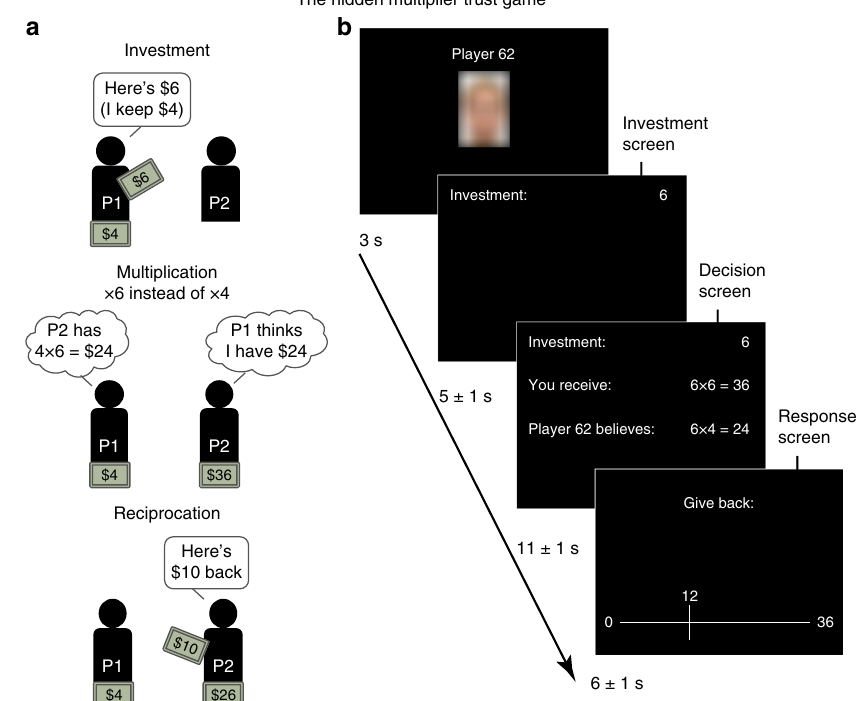
Fig. 1 Task. a Schematic representation of the Hidden Multiplier Trust Game. P1 is the Investor; P2 is the Trustee. The participants in the current study always played as Trustee. b Trial timeline. The participant was instructed to make his decision during the Decision screen, and to use the Response screen only for carrying out the behavioral